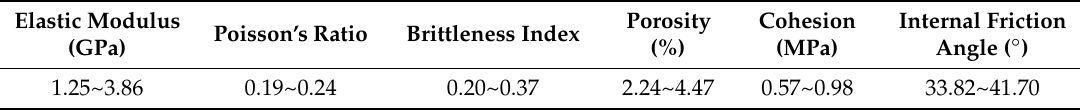
Table 3. Physical and mechanical parameters of shale samples.